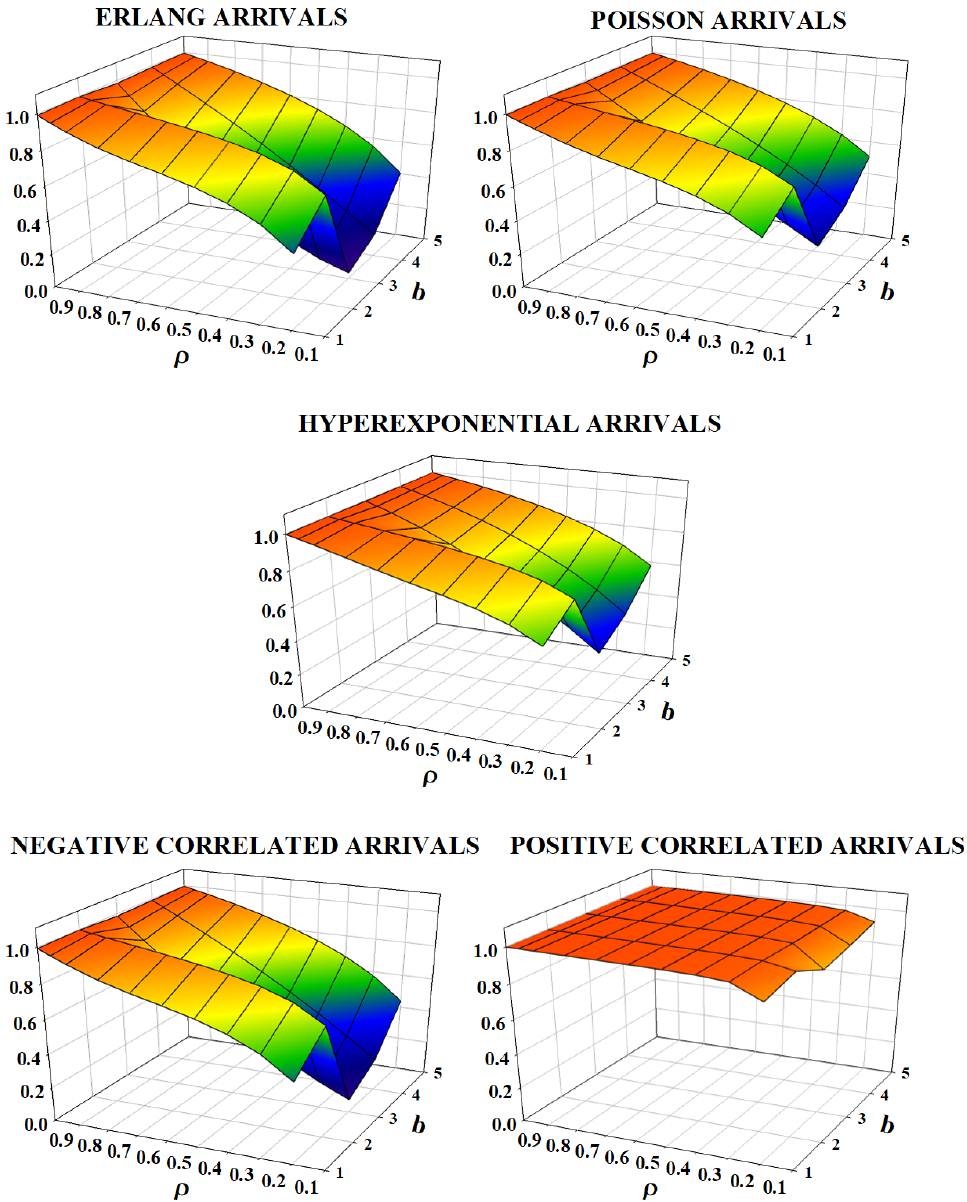
Figure 16. Spectral radius ( η ) for example